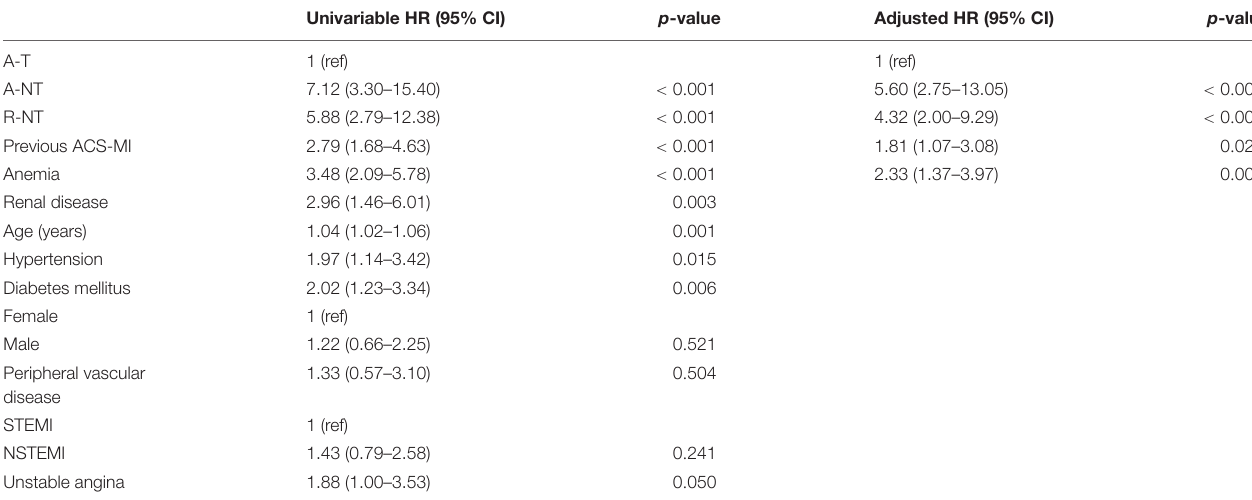
TABLE 4 | Univariable and multivariable Cox regression analyses for the composite endpoint.